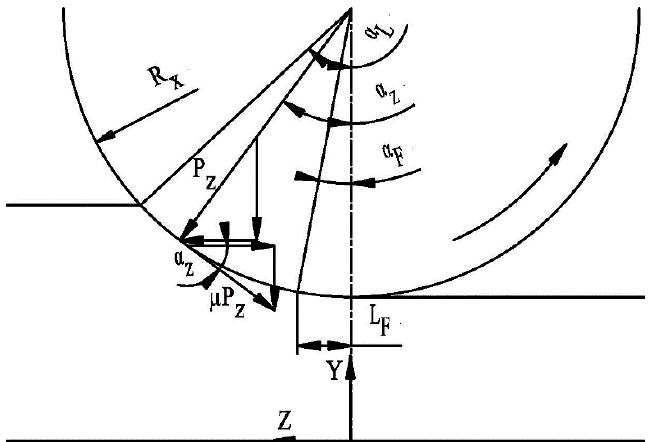
Figure 4. The forces acting on one unit width of the contact arc.